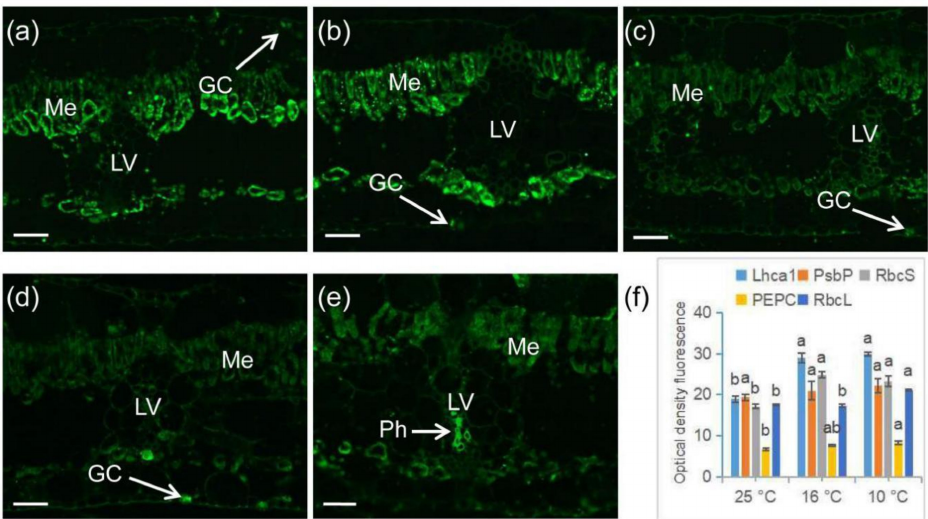
Figure 9. Distribution and localization of proteins involved in photosynthesis and changes in their levels in banana ( Musa spp. AAA) in response to chilling stress. ( a ) AS01005 antibody recognizing PSI type I chlorophyll a / b-binding protein (Lhca1); ( b ) AS06142-23 antibody recognizing the